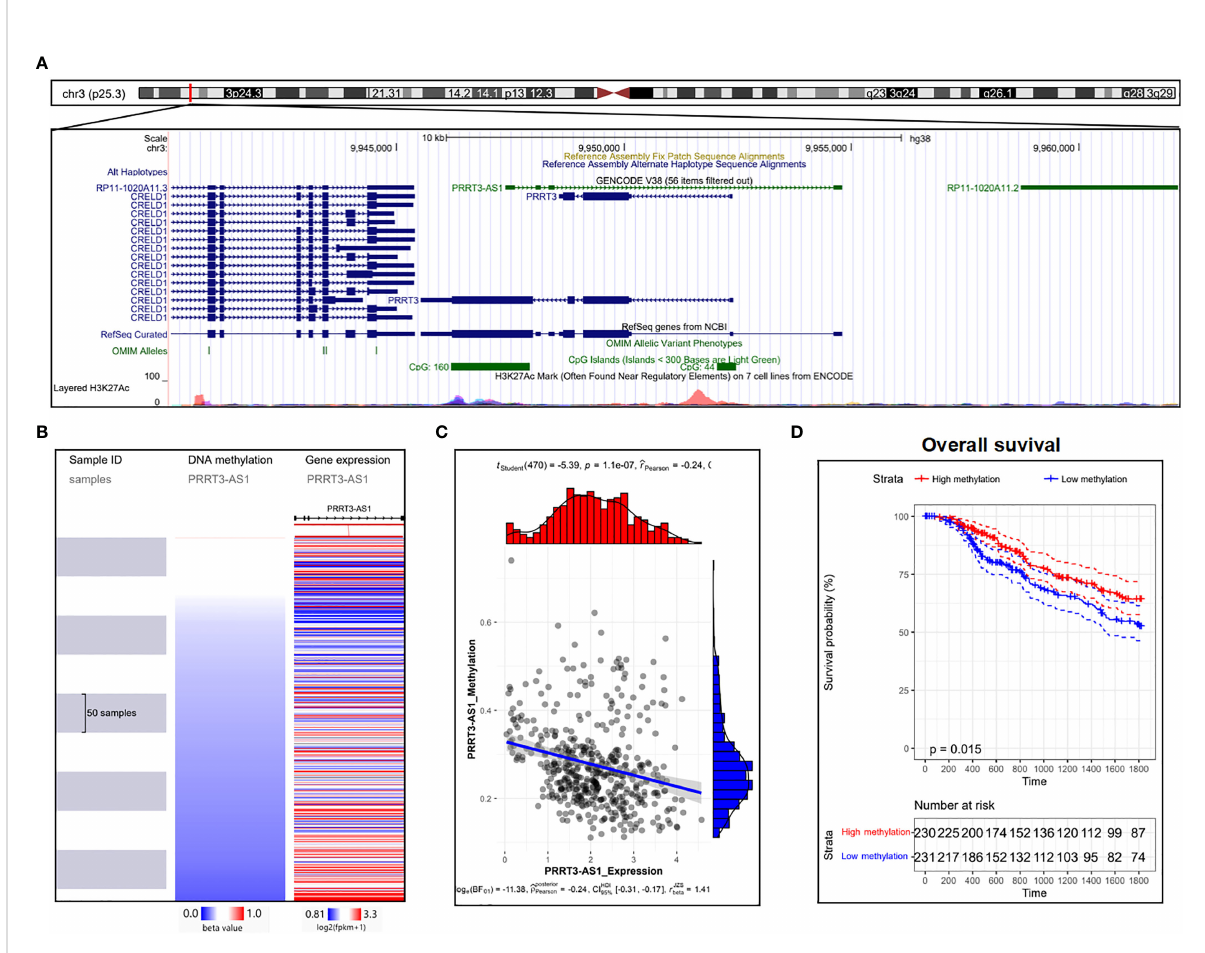
FIGURE 6 DNA methylation analysis of PRRT3-AS1 in TCGA-SKCM. (A) CpG islands of PRRT3-AS1 in the human genome. (B) Distribution of methylation and expression of PRRT3-AS1. (C) The distribution of methylation and the expression level of PRRT3-AS1. (D) Kaplan – Meier curve survival analysis between the high-methylation and low-methylation